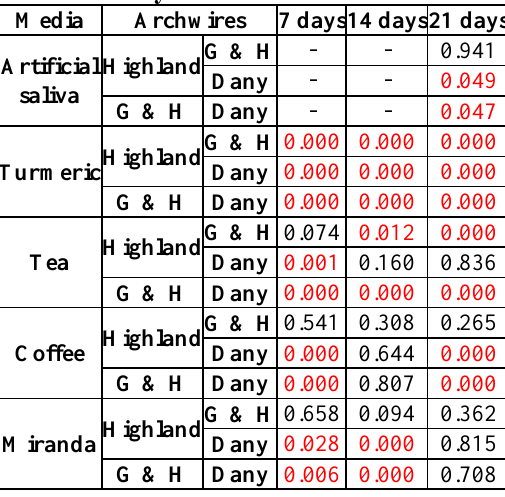
Table 4: Tukey’s HSD test after ANOVA